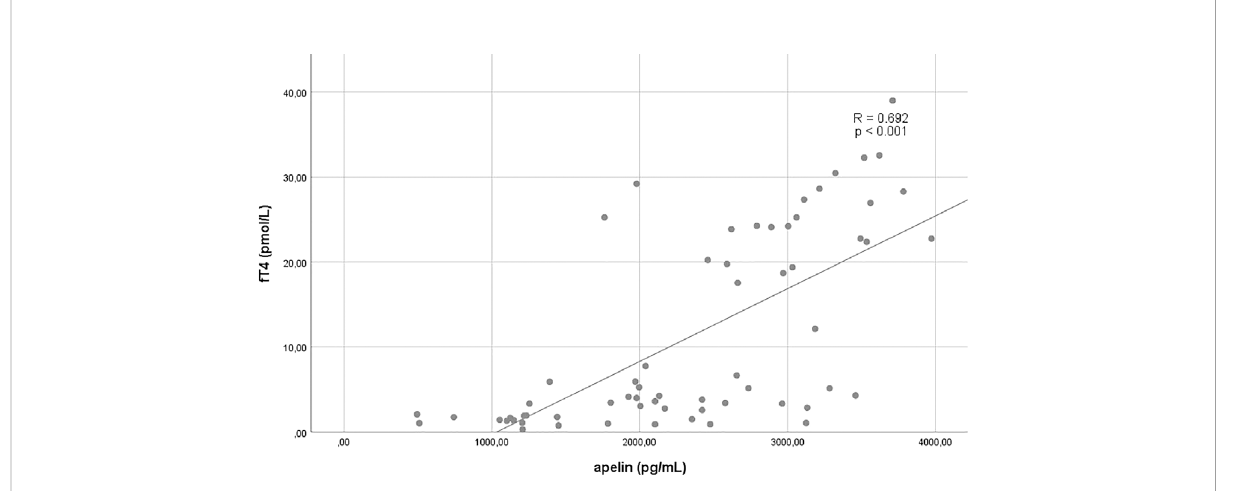
FIGURE 3 Correlation between fT4 and